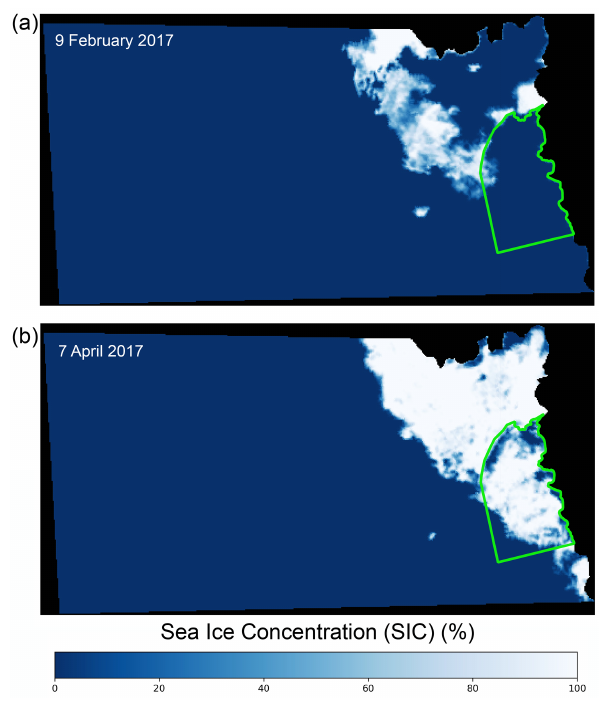
Figure 11. SIC for the broader ASP region on two dates in 2017, during and following a summer of record-low SIC. (a) An example of when the polynya had no sea ice boundary to the west/northwest due to the exceptionally low SIC in the region during the 2016/17 summer. (b) An example of the low SIC in the region early in the subsequent winter, when only a narrow area of pack ice and polynya ice fills the area. The area corresponds to that shown by the red box in Fig.